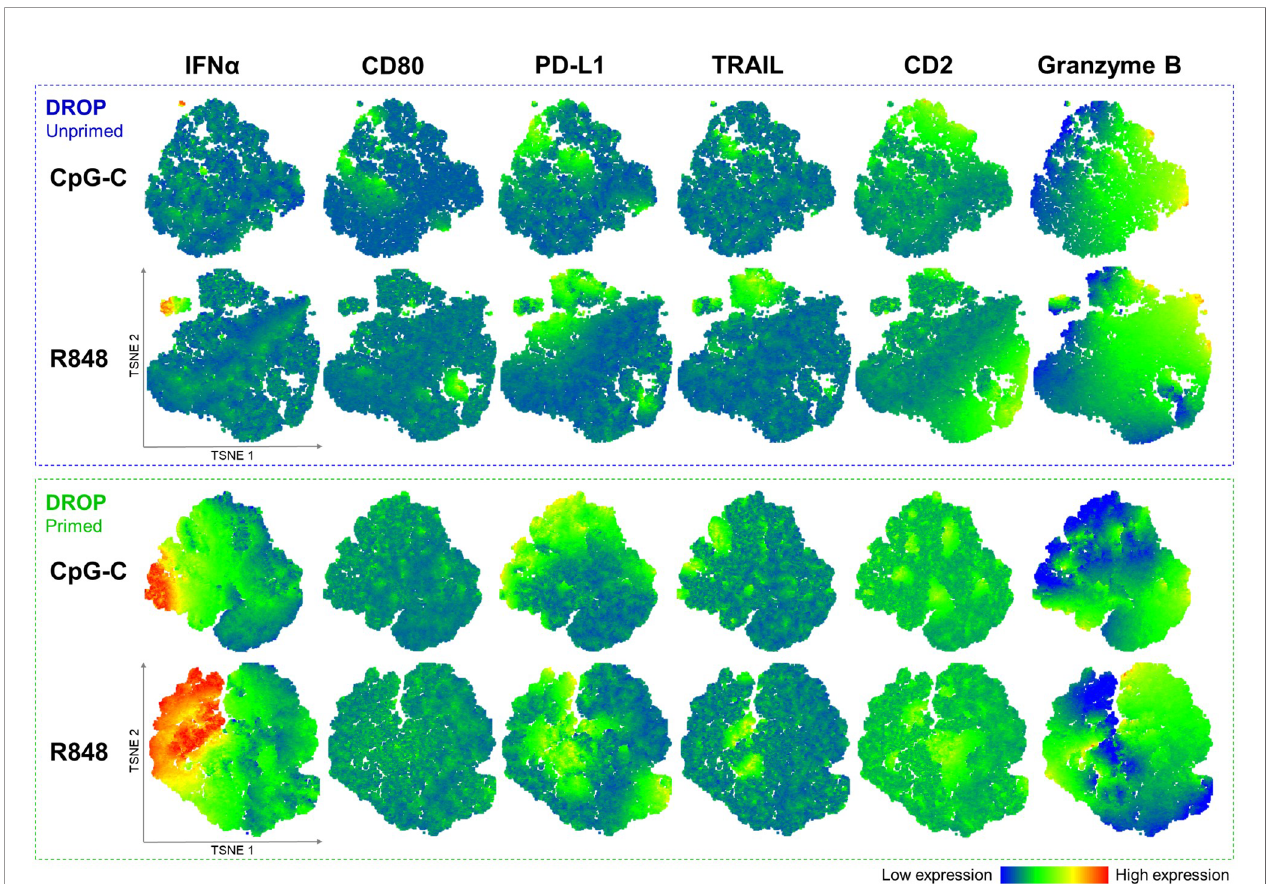
FIGURE 5 | Multi-dimensional data analysis shows clustering of early IFN a -producing pDCs with co-expression of PD-L1 and TRAIL. Single pDCs were either primed or left unprimed, incubated with IFN a Catch Reagent, activated with 50 m g/mL CpG-C or R848 for 18 hours, retrieved, stained for viability and markers of interest, and analyzed with fl ow cytometry as described earlier. Depicted are t-SNE plots based on the reanalysis of earlier presented data, based expression of IFN a , CD80, PD-L1, TRAIL, CD2, and granzyme B; DROP-Unprimed n = 10; DROP-Primed n = 5. Individual events are colored according to the expression of each indicated marker. Corresponding heatmap indicates the level of expression from low (blue) to high (red). Iterations 1000, perplexity